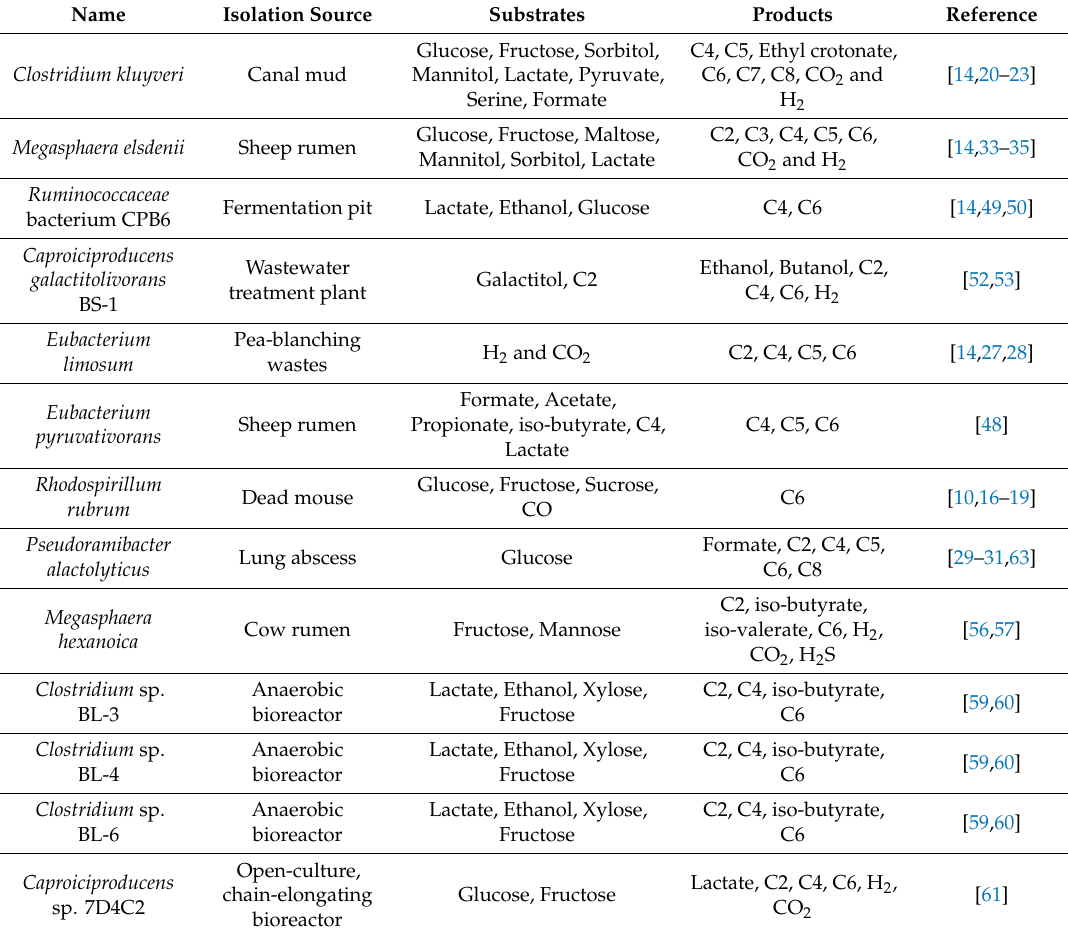
Table 2. Isolated bacterial strains known to produce